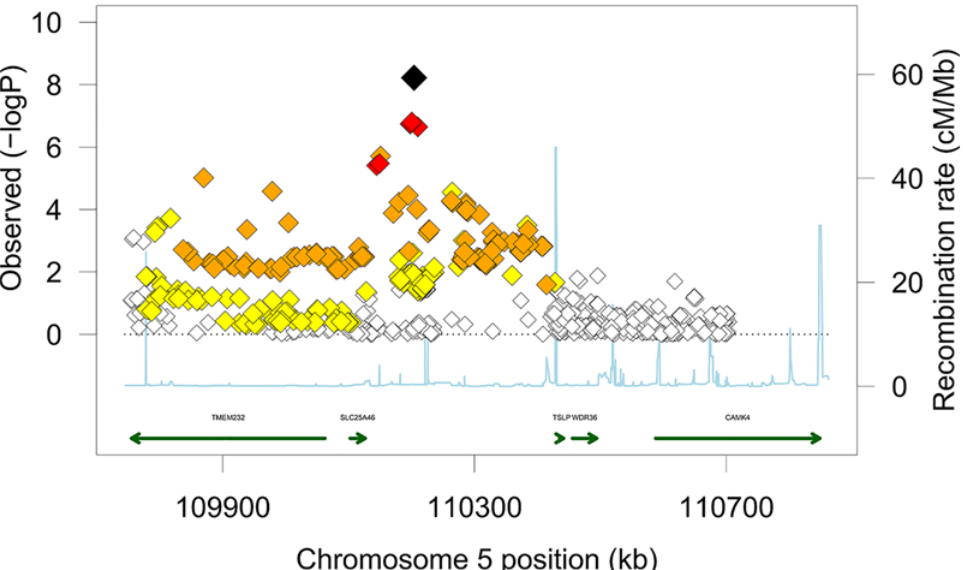
Fig 1. Regional association plot for HF mortality at the 5q22 locus. The plot covers the genomic region from 450 kb upstream of the SNP to 650 kb downstream. Diamonds represent SNPs. The large black diamond represents the SNP with the lowest P -value (rs9885413), with the P -value from the combined meta-analysis presented. Diamond color represents strength of pairwise correlation with the strongest SNP. Red represents r 2 (cid:3) 0.8, orange represents r 2 0.5 – 0.8, yellow represents r 2 0.2 – 0.5, and white represents r 2 < 0.2. Recombination rate is plotted in the background and known genes are represented in the bottom of the plot. Positions refer to NCBI build 36. SNP correlations and recombination rates were obtained from HapMap release 22.